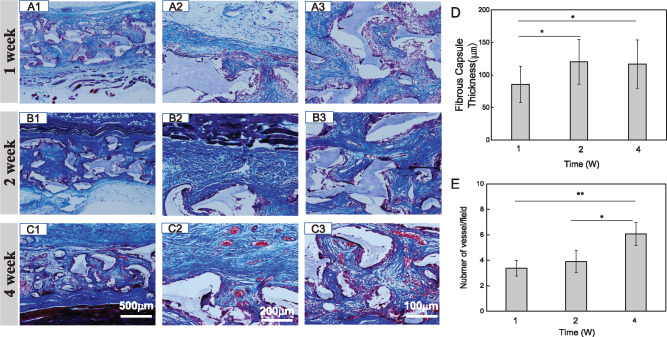
Masson staining sections of B-PE scaffolds for quantification of visualization and collagen deposition after being implanted for (A) 1, (B) 2 and (C) 4 weeks, respectively. The fibrous capsule thickness (D) and numbers of newly formed blood vessels (E) in tissue sections of B-PE scaffolds